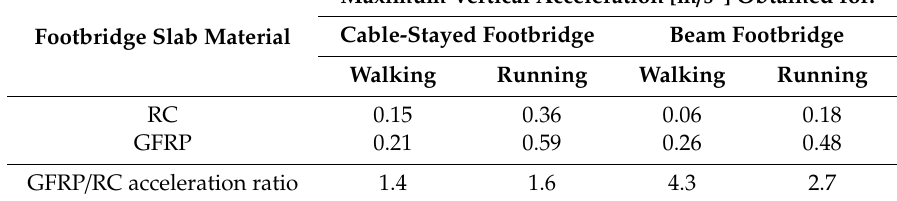
Table 16. Comparison of the maximum accelerations of the footbridges with the traditional RC or the innovative GFRP slab material.